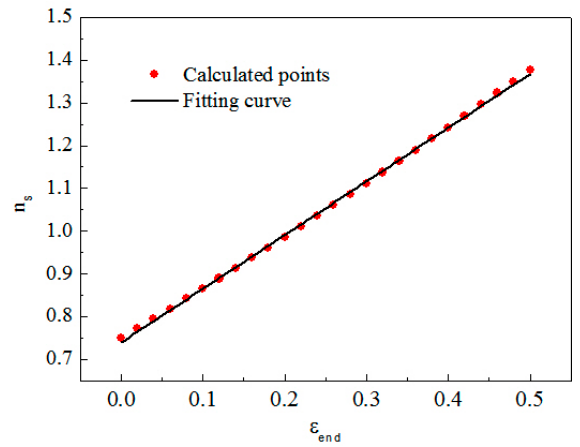
Figure 15. Relation between the optimum specimen slenderness ratio and the final strain of the Figure15. specimen.